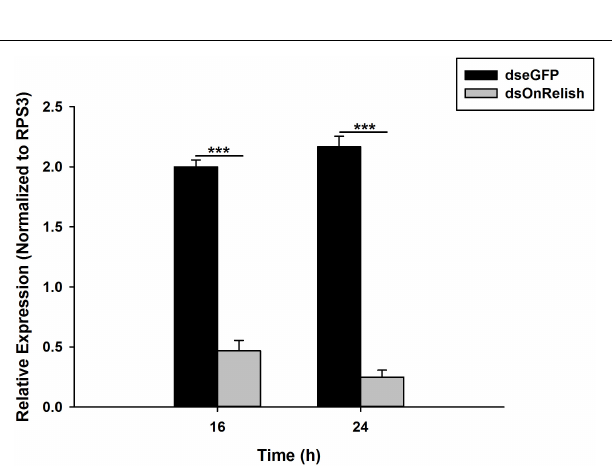
FIGURE 7 | Detections of the RNAi efficiency of OnRelish. Relative mRNA expression levels of OnRelish by qRT–PCR. dsOnRel and dsGFP were injected to third instar larvae and samples were taken at 16 and 24 h after injection. ∗∗∗ P < 0.0001 indicates significantly different levels between two